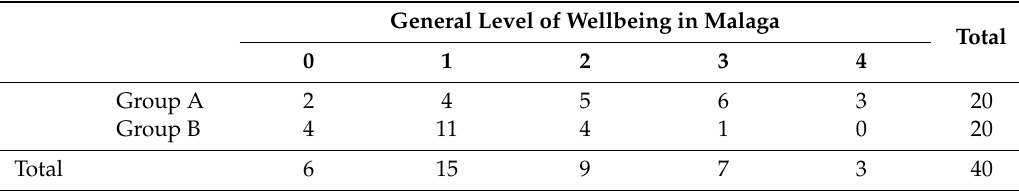
Table 15. E ff ect of the learning group on the general level of wellbeing in Malaga